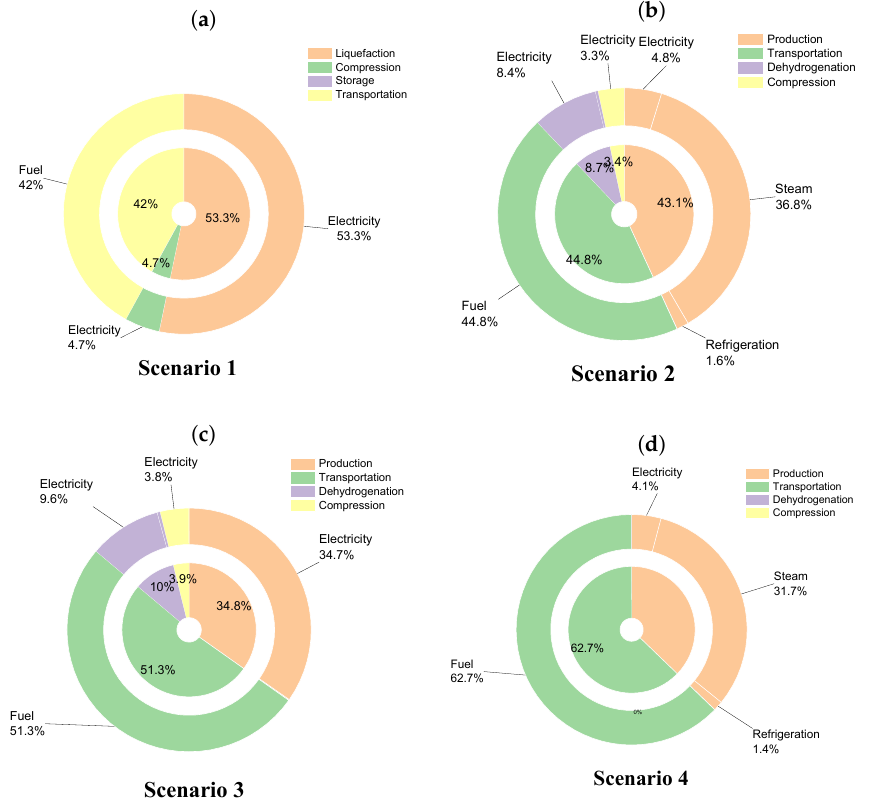
Figure 2. OPEX broken-down into utilities used in specific sections. ( a – d ) correspond to the OPEX evaluation results of scenarios 1–4 listed in Table 2, where the relative contribution of each cost factor is shown. Individual legends are used for the